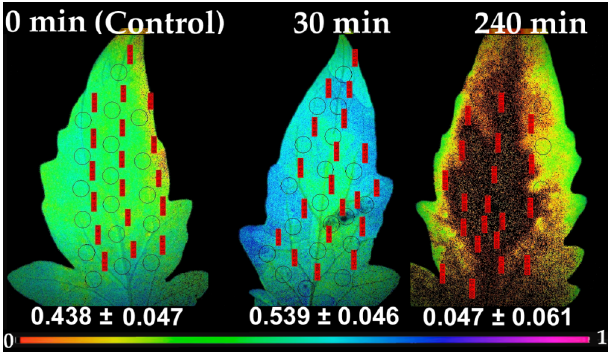
Figure 7. Chlorophyll fluorescence images of the fraction of open PSII reaction centers ( q P ), measured at 640 μ mol photons m − 2 s –1 , before (0 min, control) and after 30 and 240 min of B. cinerea spore suspension application on tomato leaflets. The color code depicted at the bottom ranges from values 0.0 to 1.0. The circles in each image denote the areas of interest (AOI) that were selected in each leaflet and are complemented by red labels with q P values, while whole leaflet value is presented.